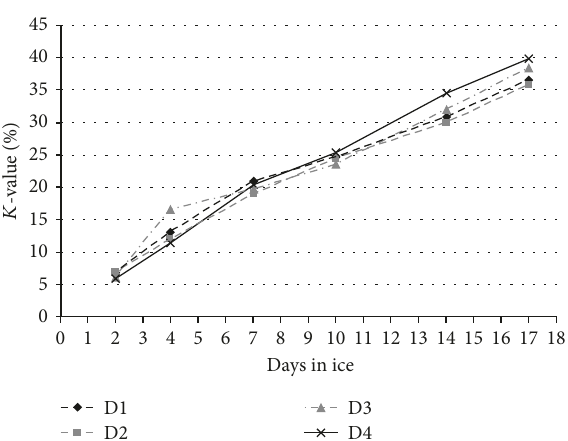
Figure 4: 𝐾 -value (%) of the four gilthead sea bream dietary groups (D1–D4) stored in